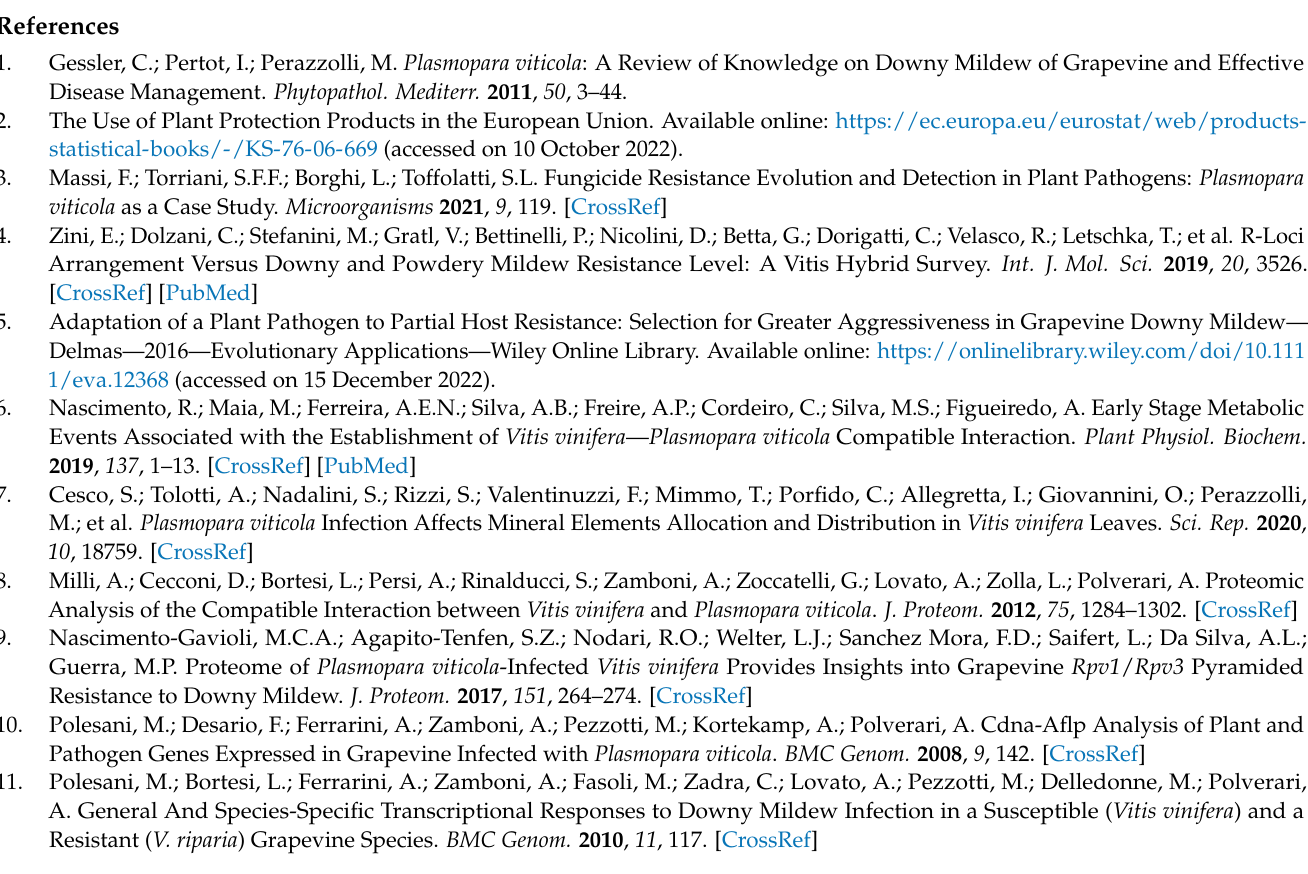
scripts primer sequences, amplicon length, amplification efficiency, annealing and melting temper- ature are represented; Table S2. General features of Vitis vinifera phospholipases C superfamily. Proposed grapevine PLC nomenclature, gene locus, protein and nucleotide accessions (from NCBI), chromosome location, exon number, protein length, molecular weight (Mw) and isoelectric point (pI) are represented; Table S3. General features of Vitis vinifera phospholipases D superfamily. Pro- posed grapevine PLD nomenclature, gene locus, protein and nucleotide accessions (from NCBI), chromosome location, exon number, protein length, molecular weight (Mw) and isoelectric point (pI) are represented; Table S4. Cis-elements identified in all PLC and PLD grapevine gene family members; Table S5. Subcellular prediction of the Vitis vinifera phospholipase C and D proteins; Table S6. Biological process and function of the Vitis vinifera phospholipases D’ proteins; Figure S1. Melting curves of targeted genes. A) EF1 α ; B) UBQ ; C) VviPI-PLC1 ; D) VviPI-PLC2; E) VviPI-PLC7